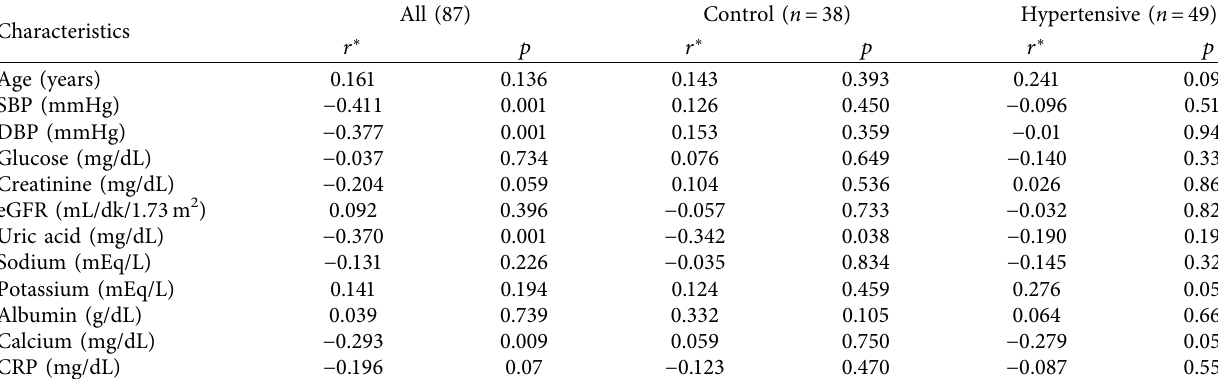
Table 2: Correlation between the serum calprotectin level and other findings of the study population.